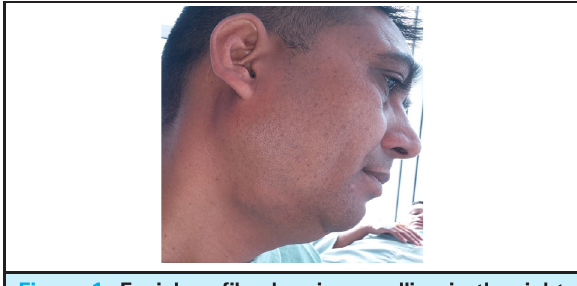
Figure 4 . Tumour showing epithelial